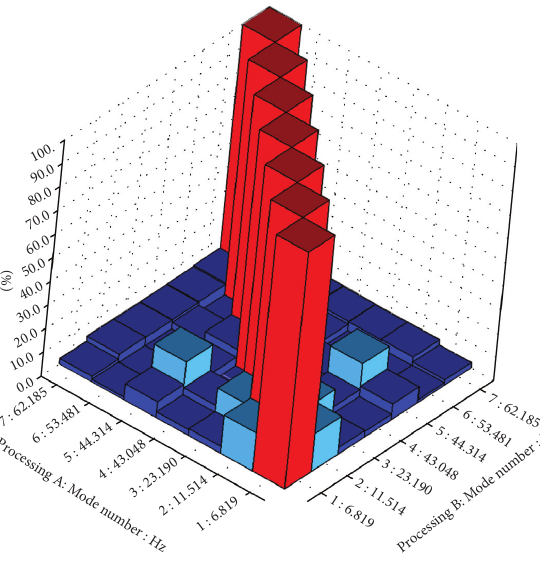
Figure 20: The MAC matrix of the Table 9: Seven stages of natural frequencies and correlation coefficients (%) of the SHEP.